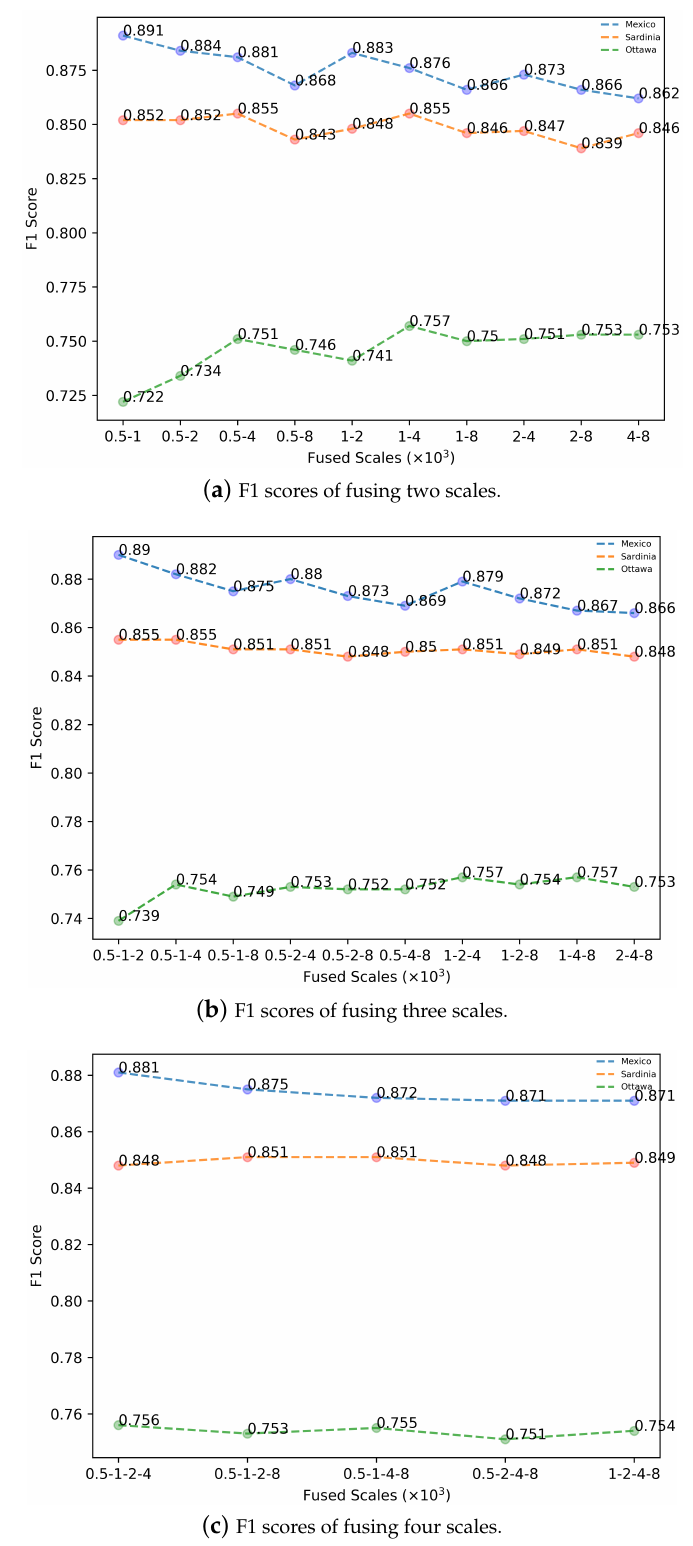
( a ) F1 scores of fusing two scales.